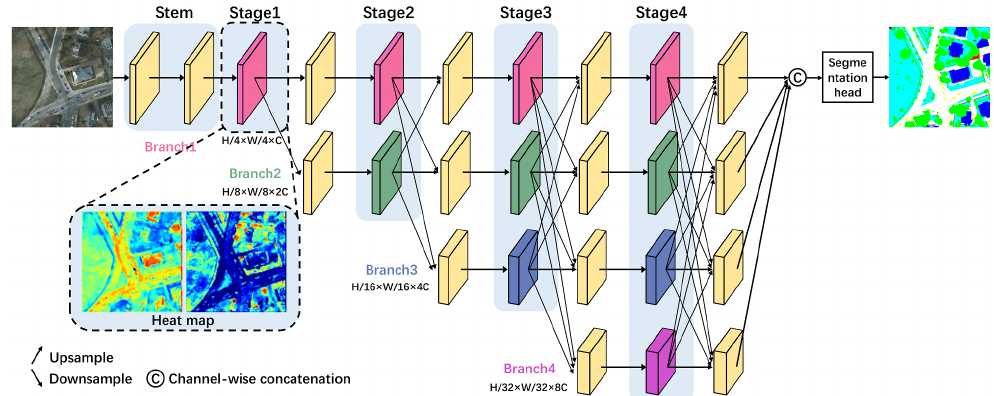
Figure 2. Illustrating the architecture of HRNet. The rectangular blocks represent the feature maps, and ’ −→ ’ represents the convolution operation. Stem is the downsampling